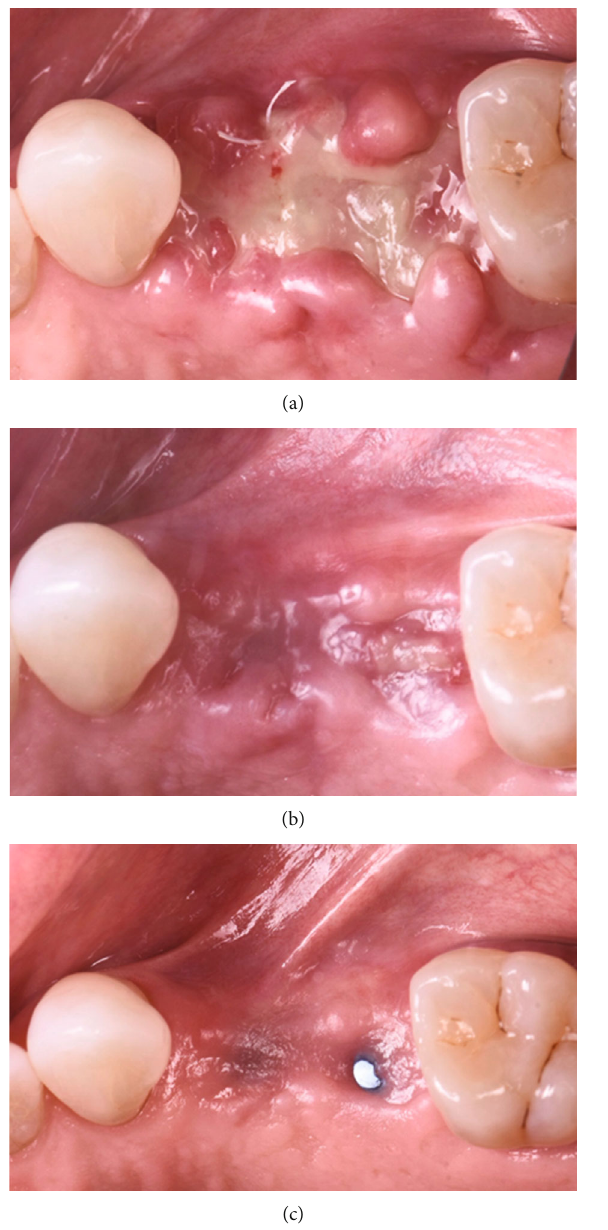
Figure 6: (a) At three months postimplant placement, the radiograph showed slight crestal bone loss. (b) Implants exposure with healing abutments. (c) Two weeks healing with better soft tissue healing and healthier-looking